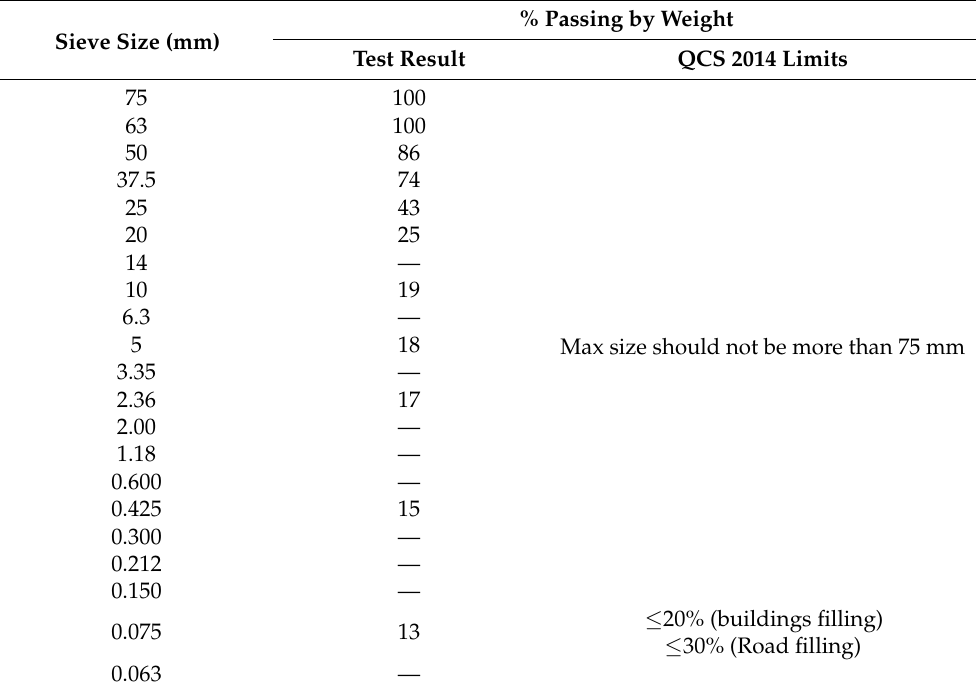
Table 2. Particle size distribution (PSD) of TBM muck as building or /road fill material according to ASTM D6913 and ASTM D1140.